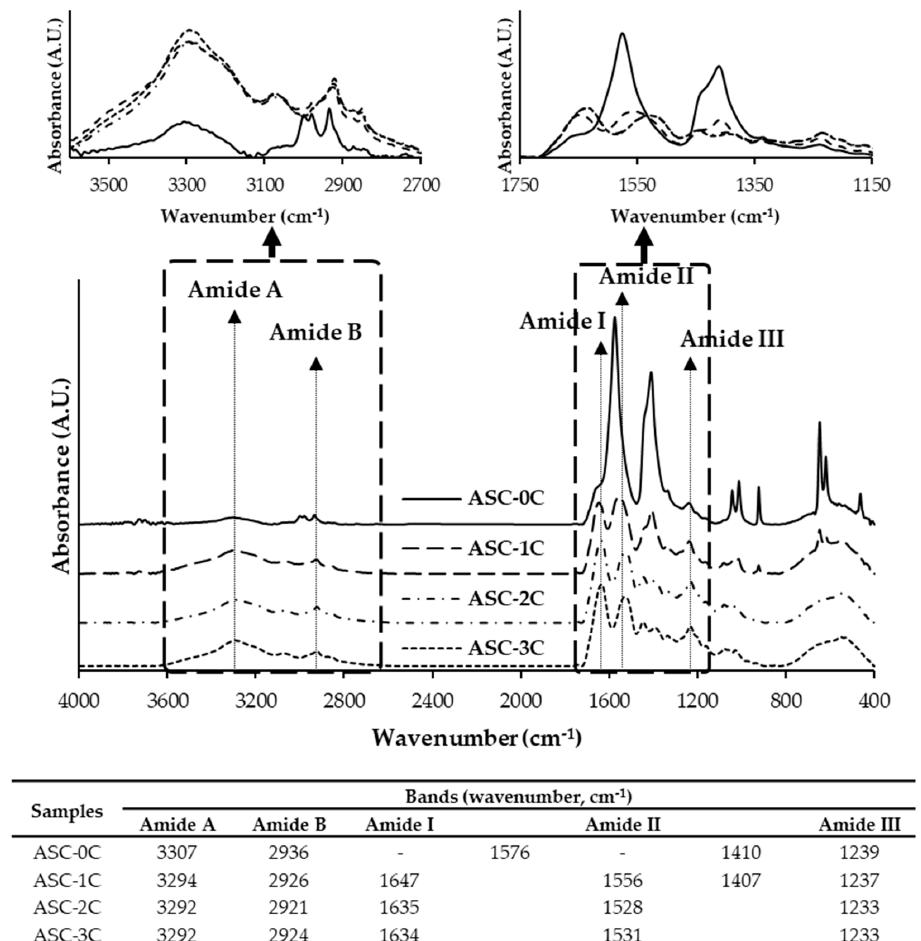
Figure 4. FTIR spectra of acid-soluble collagen from salmon skin washed with distilled water at different cycles. For the caption, see Figure 2. Table 1. Yield, compositions, and thermal properties of acid-soluble collagen from salmon